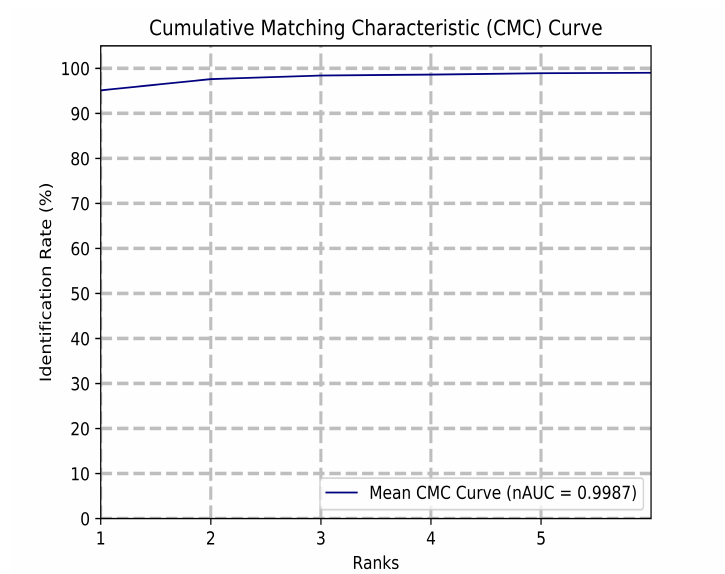
Figure 9. Cumulative matching characteristic curve for the first six ranks, and nAUC for all 200